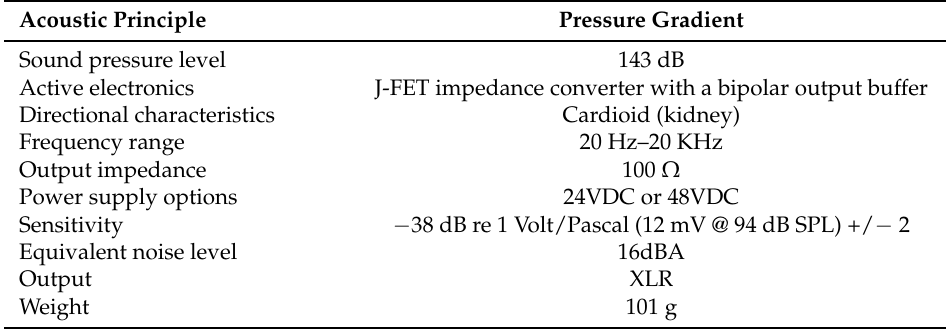
Table 2. RHODE NT5 microphone specifications.